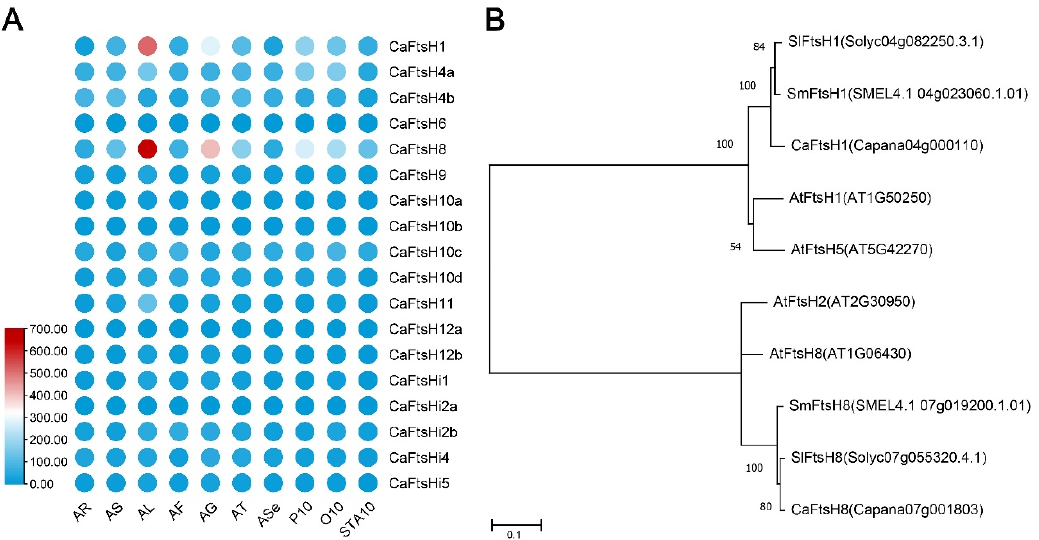
Figure 3. Expression pattern and phylogenetic analysis of CaFtsHs . ( A ) Heat map of the expression levels of 18 CaFtsH genes in diverse pepper tissues utilizing transcriptome analysis, including roots (AR), stems (AS), leaves (AL), flowers (AF), pulps (AG), placentas (AT), seeds (ASe), petals (P10), ovaries (O10), and stamens (STA10). ( B ) Phylogenetic analysis of AtFtsH1, 2, 5, 8, and their six closest homologs in C. annuum , S. lycopersicum , and S. melongena . The branch lengths represent the evolutionary distance. Numbers next to the branches denote the bootstrap values with 1000 replicates (bootstrap test).